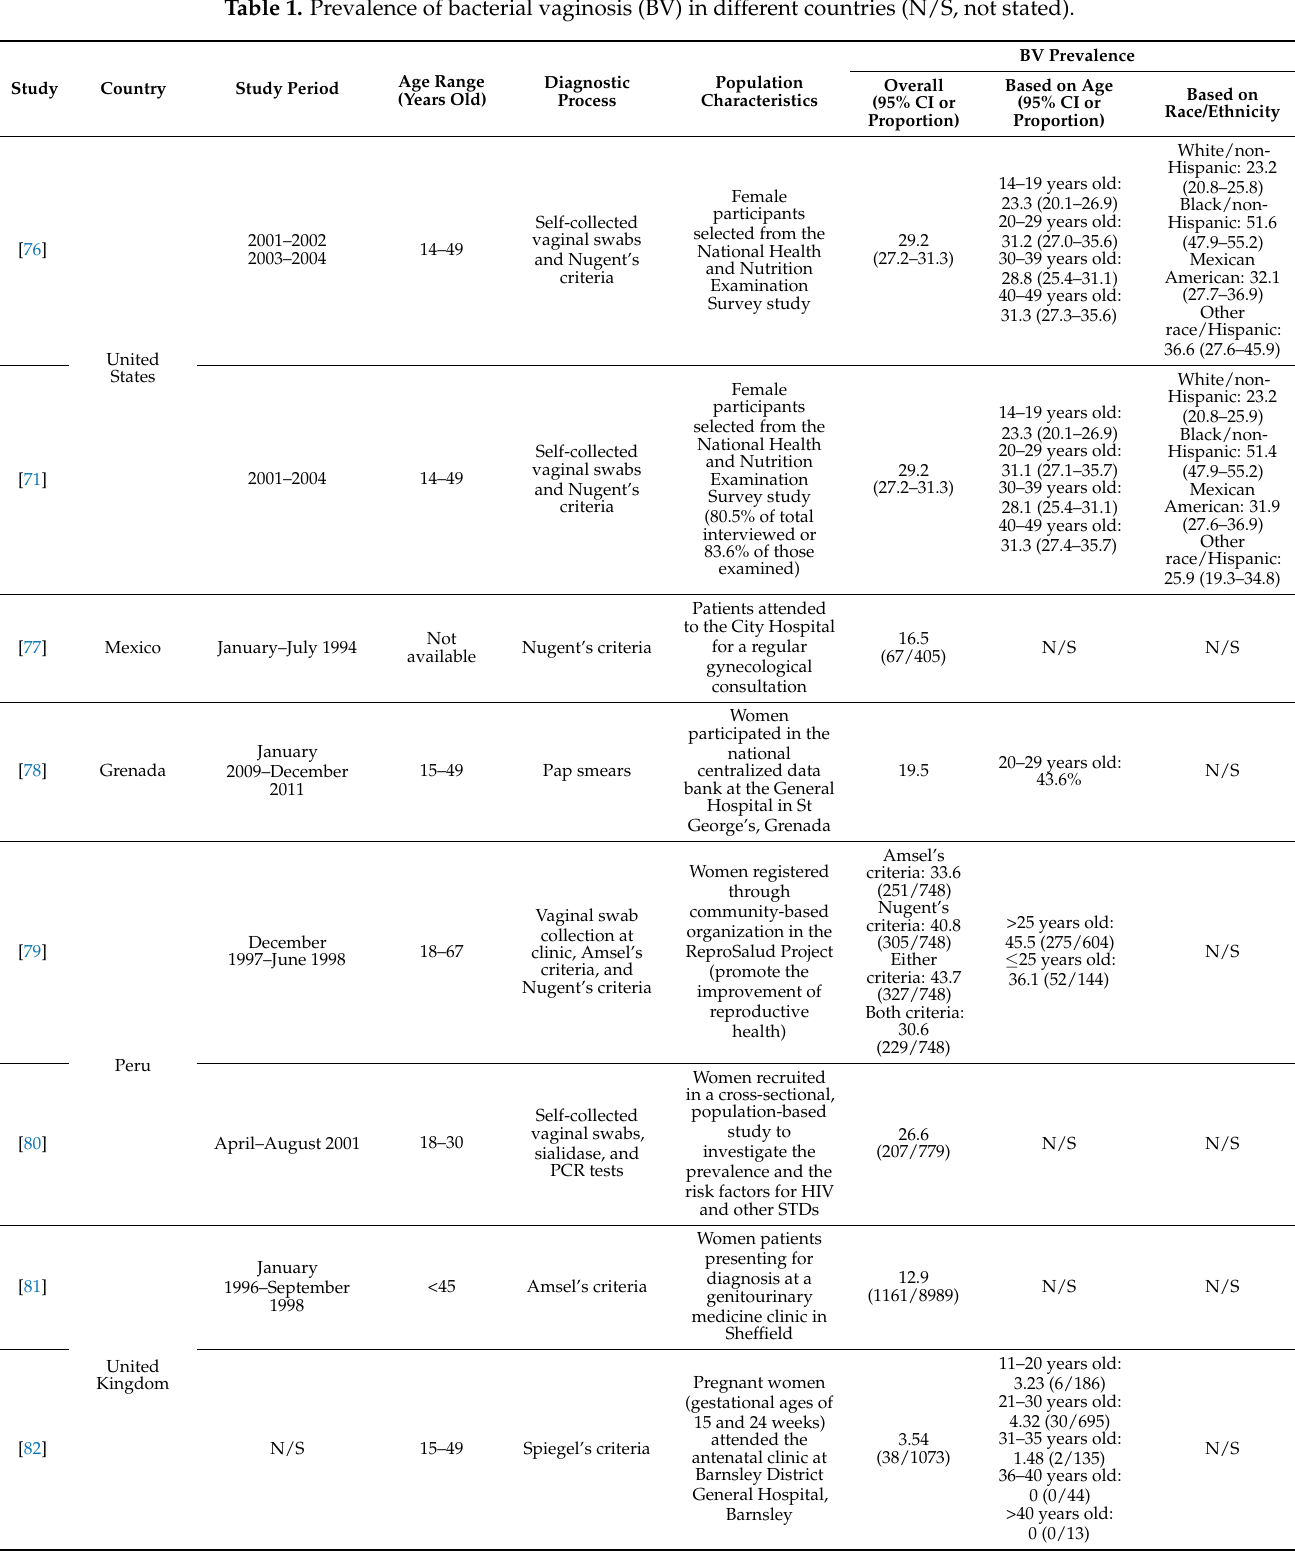
Table 1. Prevalence of bacterial vaginosis (BV) in different countries (N/S, not